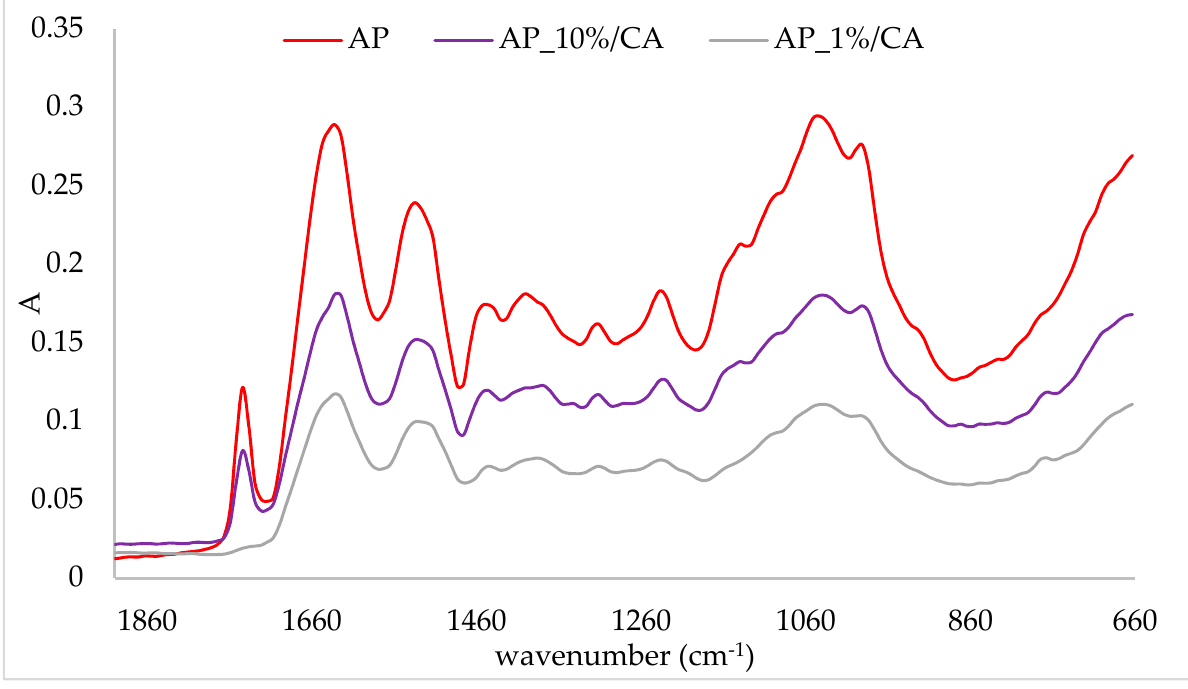
Figure 3. IR spectra of pumpkin protein (PuP) and obtained complexes with cinnamic acid (PuP_10%CA—complex prepared with 10% of protein matrix; PuP_1%CA—complex prepared with 1% of protein matrix).